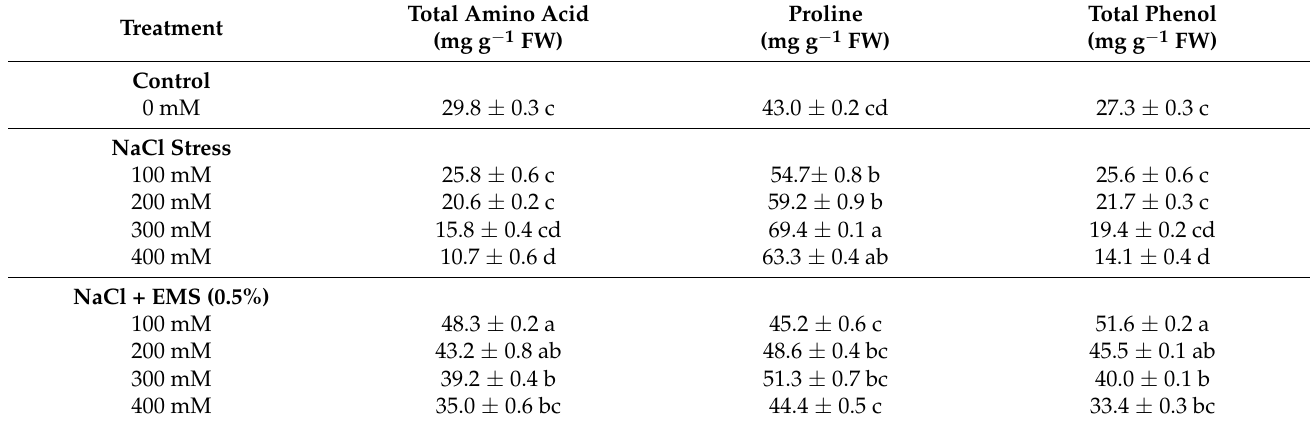
Table 2. Mutagenic effect of sodium chloride (NaCl) and ethyl methane sulphonate (EMS) on total free amino acids, proline, and total phenol contents of callus of A. vulgaris. The values reflect the mean standard deviation of three independent experiments. According to DMRT, means separated by different letters are significantly different from each other at 5% level of significance ( p ≤ 0.05).